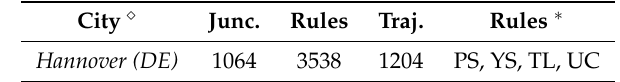
Table 2. Dataset used for testing the proposed